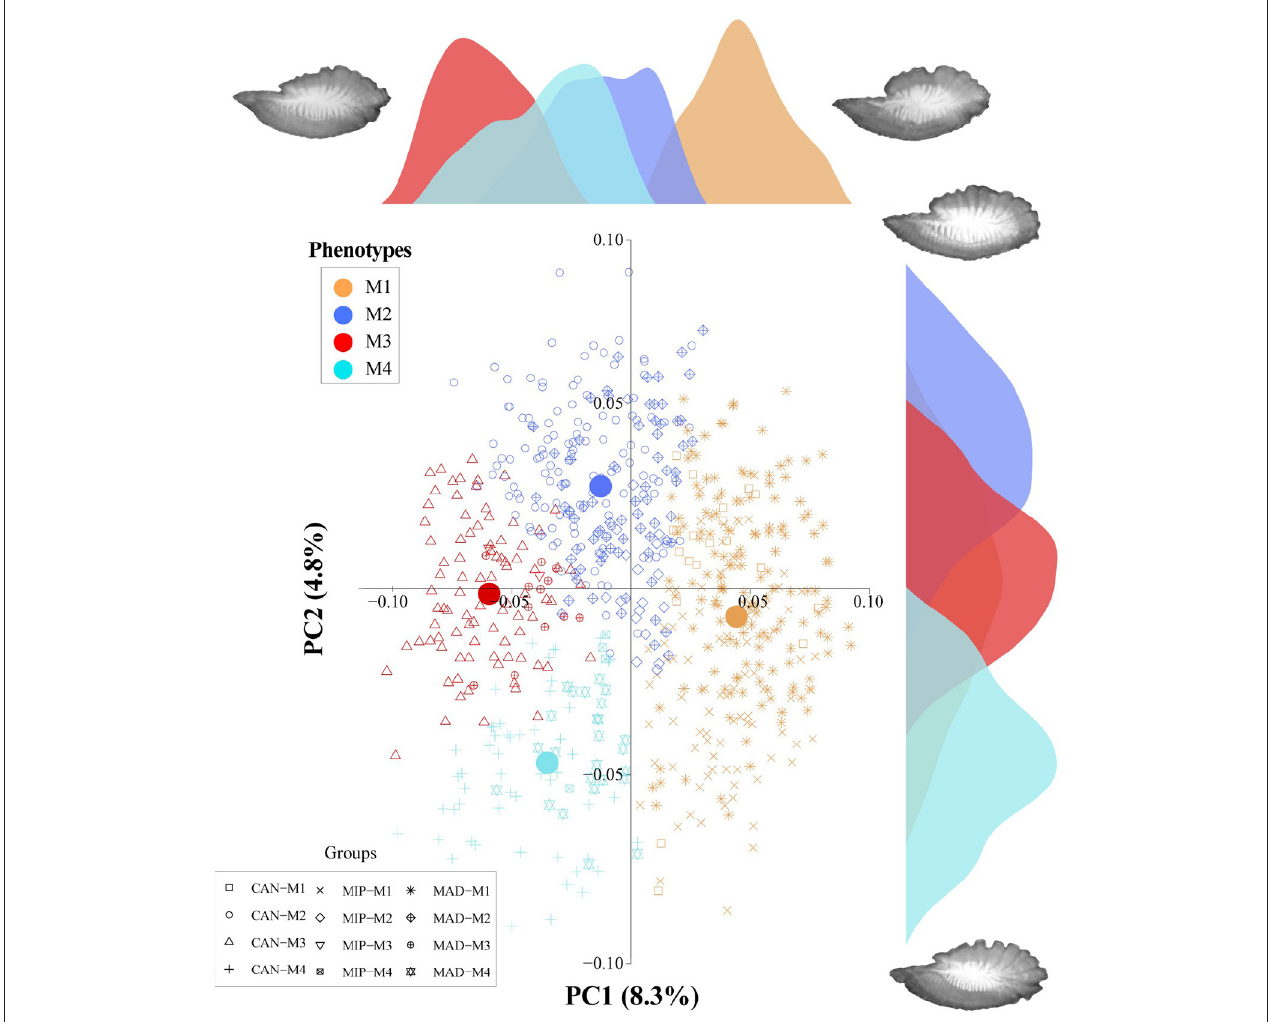
FIGURE 2 | Scatterplot of the first and second axes of the PCA and marginal density distribution plots of the four morphotypes found in Trachurus picturatus from the north and central eastern Atlantic Ocean. CAN, Canary Islands; MAD, Madeira; MIP, mainland Portugal. Color circles indicate the centroid of each morphotype.